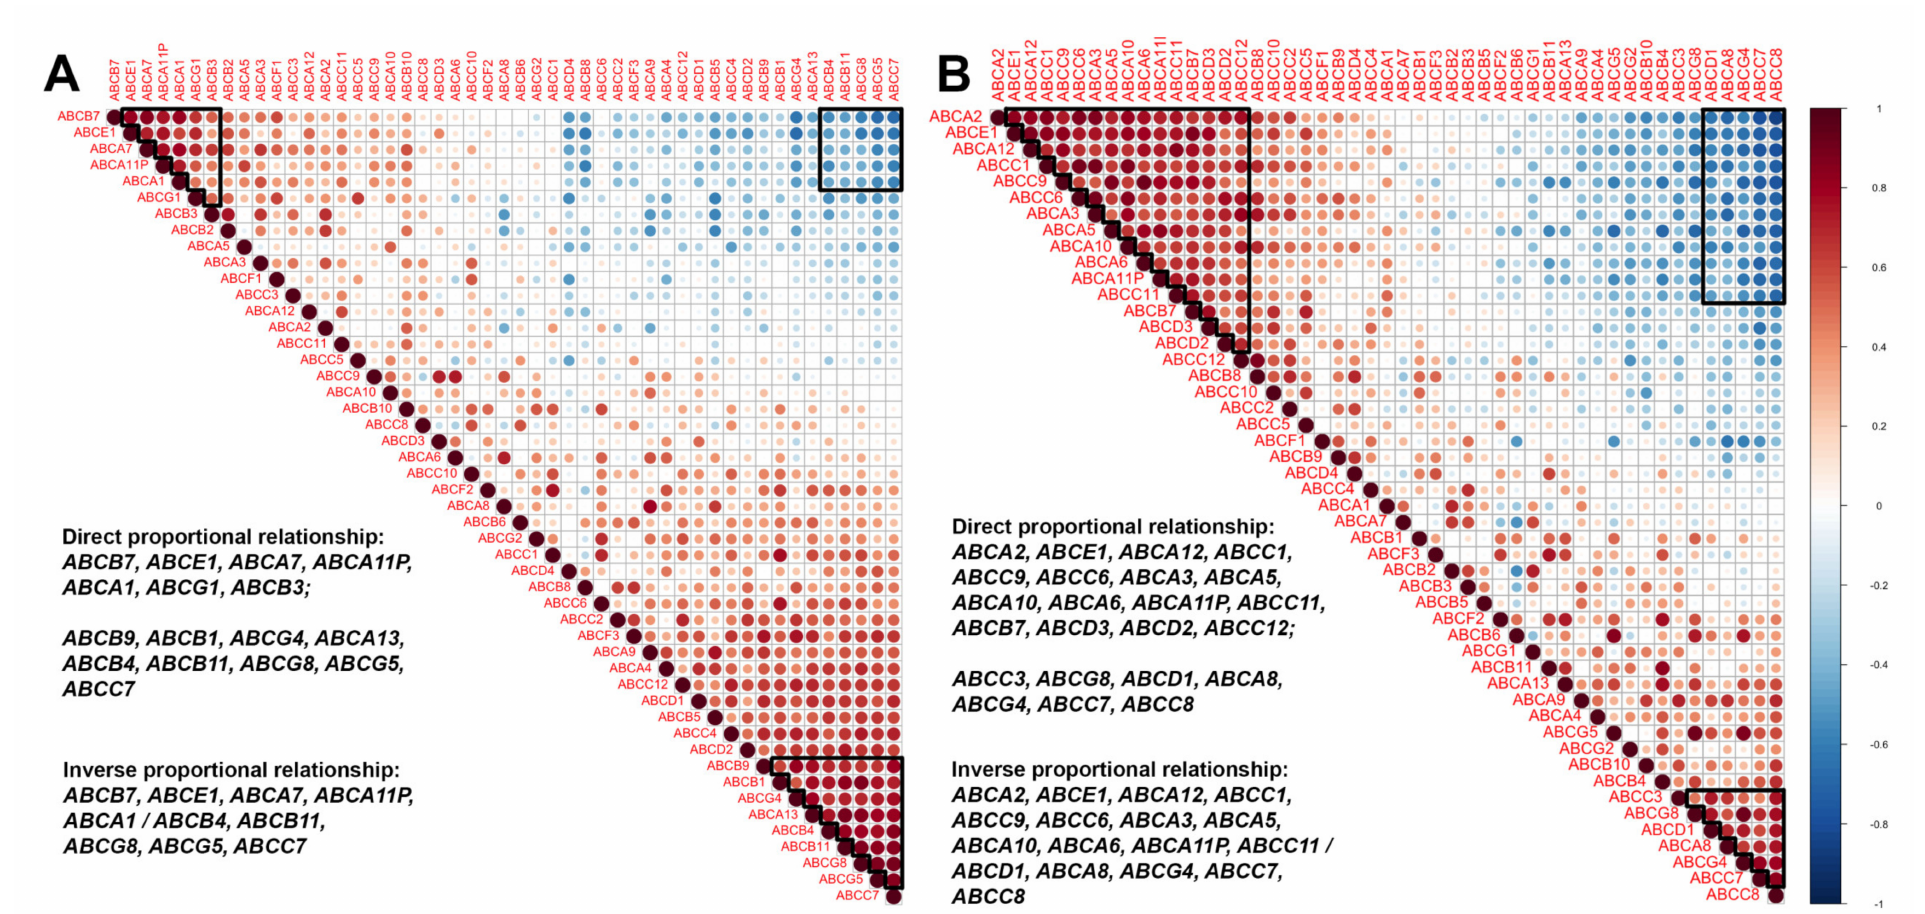
Figure 4. Correlation matrix ABC transporter gene expression before ( A ) and after ( B ) treatment in patients with objective response. Note: groups of coexpression genes marked with a black line (Spearmen coefficient, r > 0.5 or rs < − 0.5, p ≤